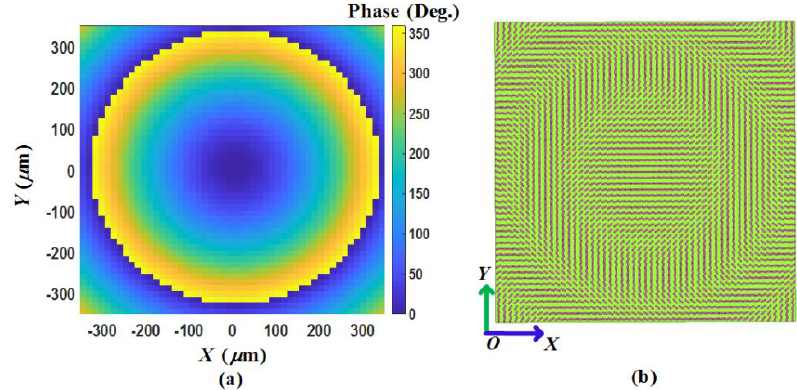
Figure 4. ( a ) The reflected phase distribution of the proposed focusing graphene metasurface with an area 714 µm × 714 µm. ( b ) The unit-cells distribution of the proposed focusing graphene metasurface with 51 × 51 unit-cells. Each unit-cell rotates a corresponding phase angle θ = φ / 2.